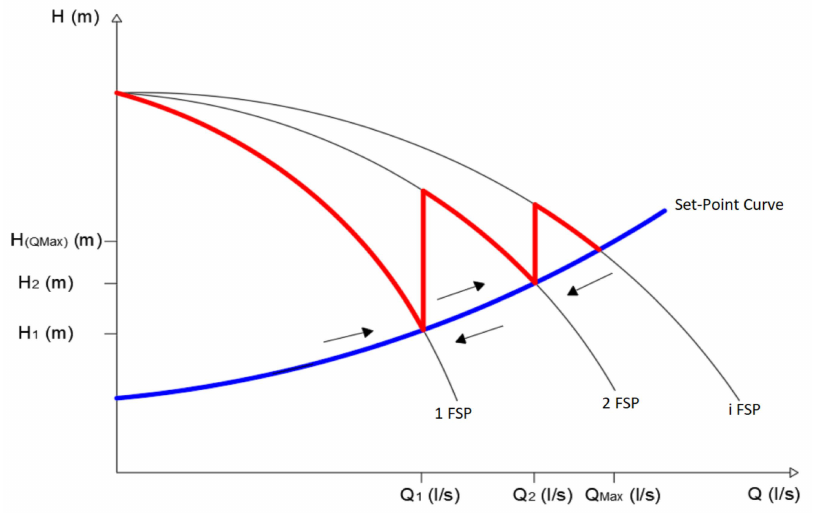
Figure A2. Flow control with FSPs regulation